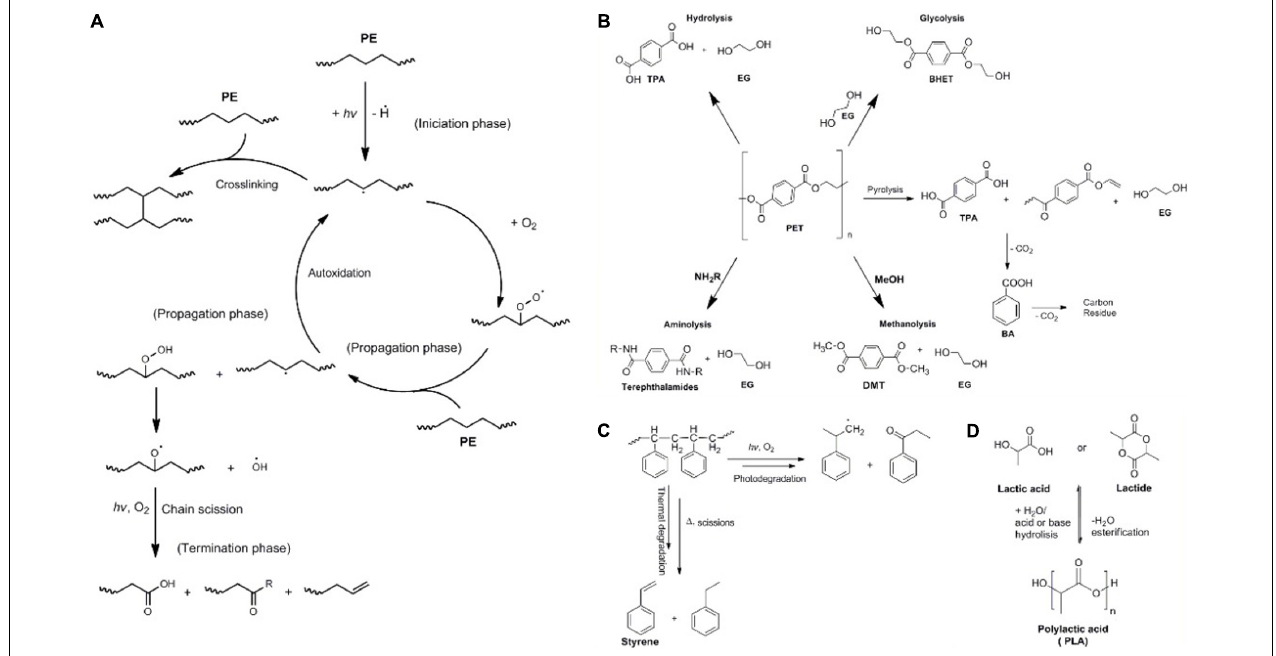
FIGURE 10 | Chemical recycling degradation reactions. (A) Photo-oxidation degradation of polyethylene. (B) Degradation of polyethylene terephthalate by pyrolysis and other methods. (C) Photo and thermal degradation of polystyrene. (D) Hydrolytic polylactic acid